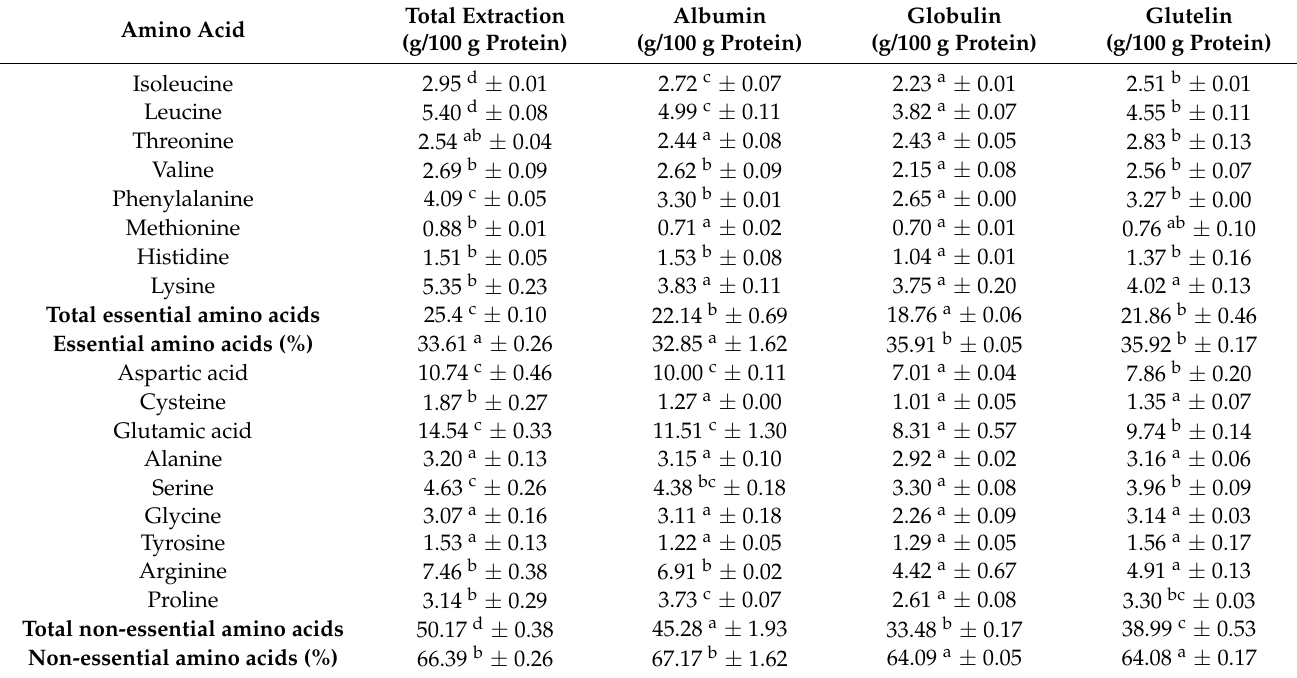
Table 3. Amino acid profile of chickpea